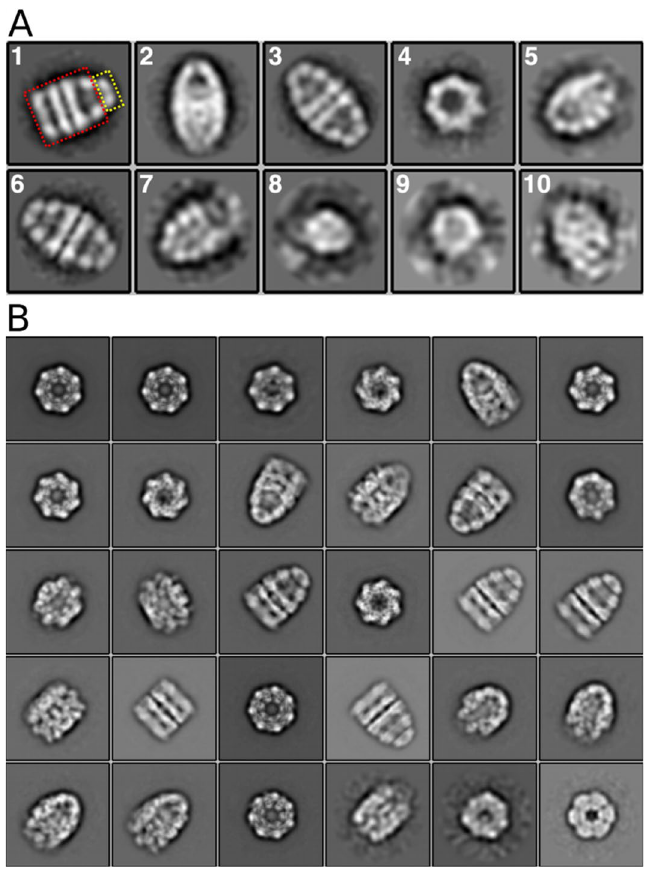
Figure 1. 2D class averages from the negatively stained ( A ) and from the cryo-EM ( B ) GroEL–GroES sample.